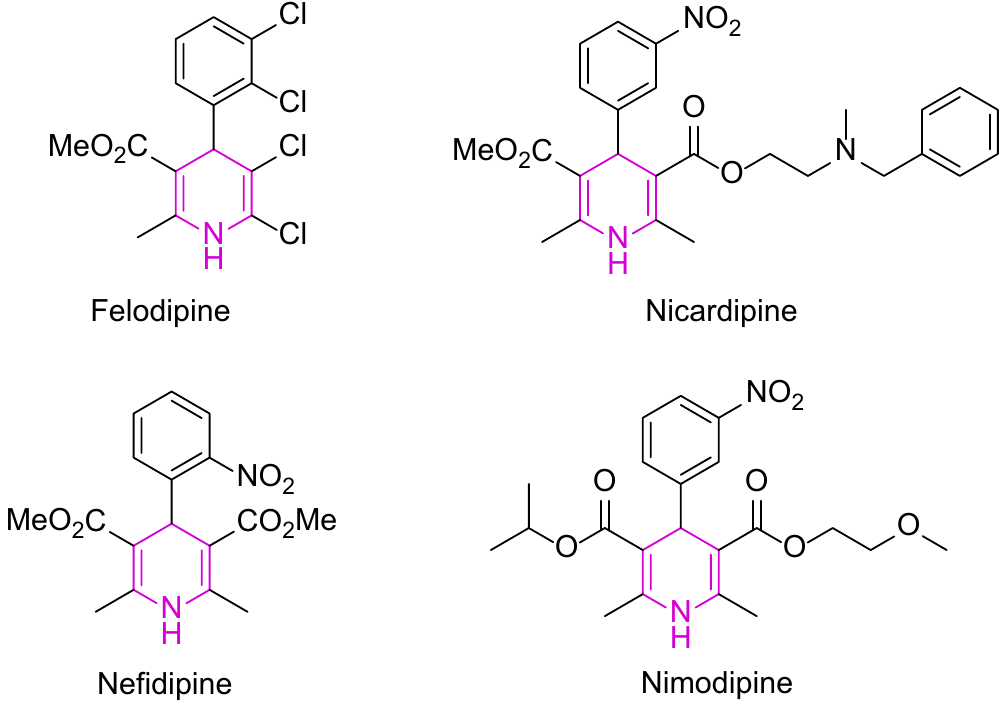
Figure 1. 1,4-DHP derivatives employed as clinical